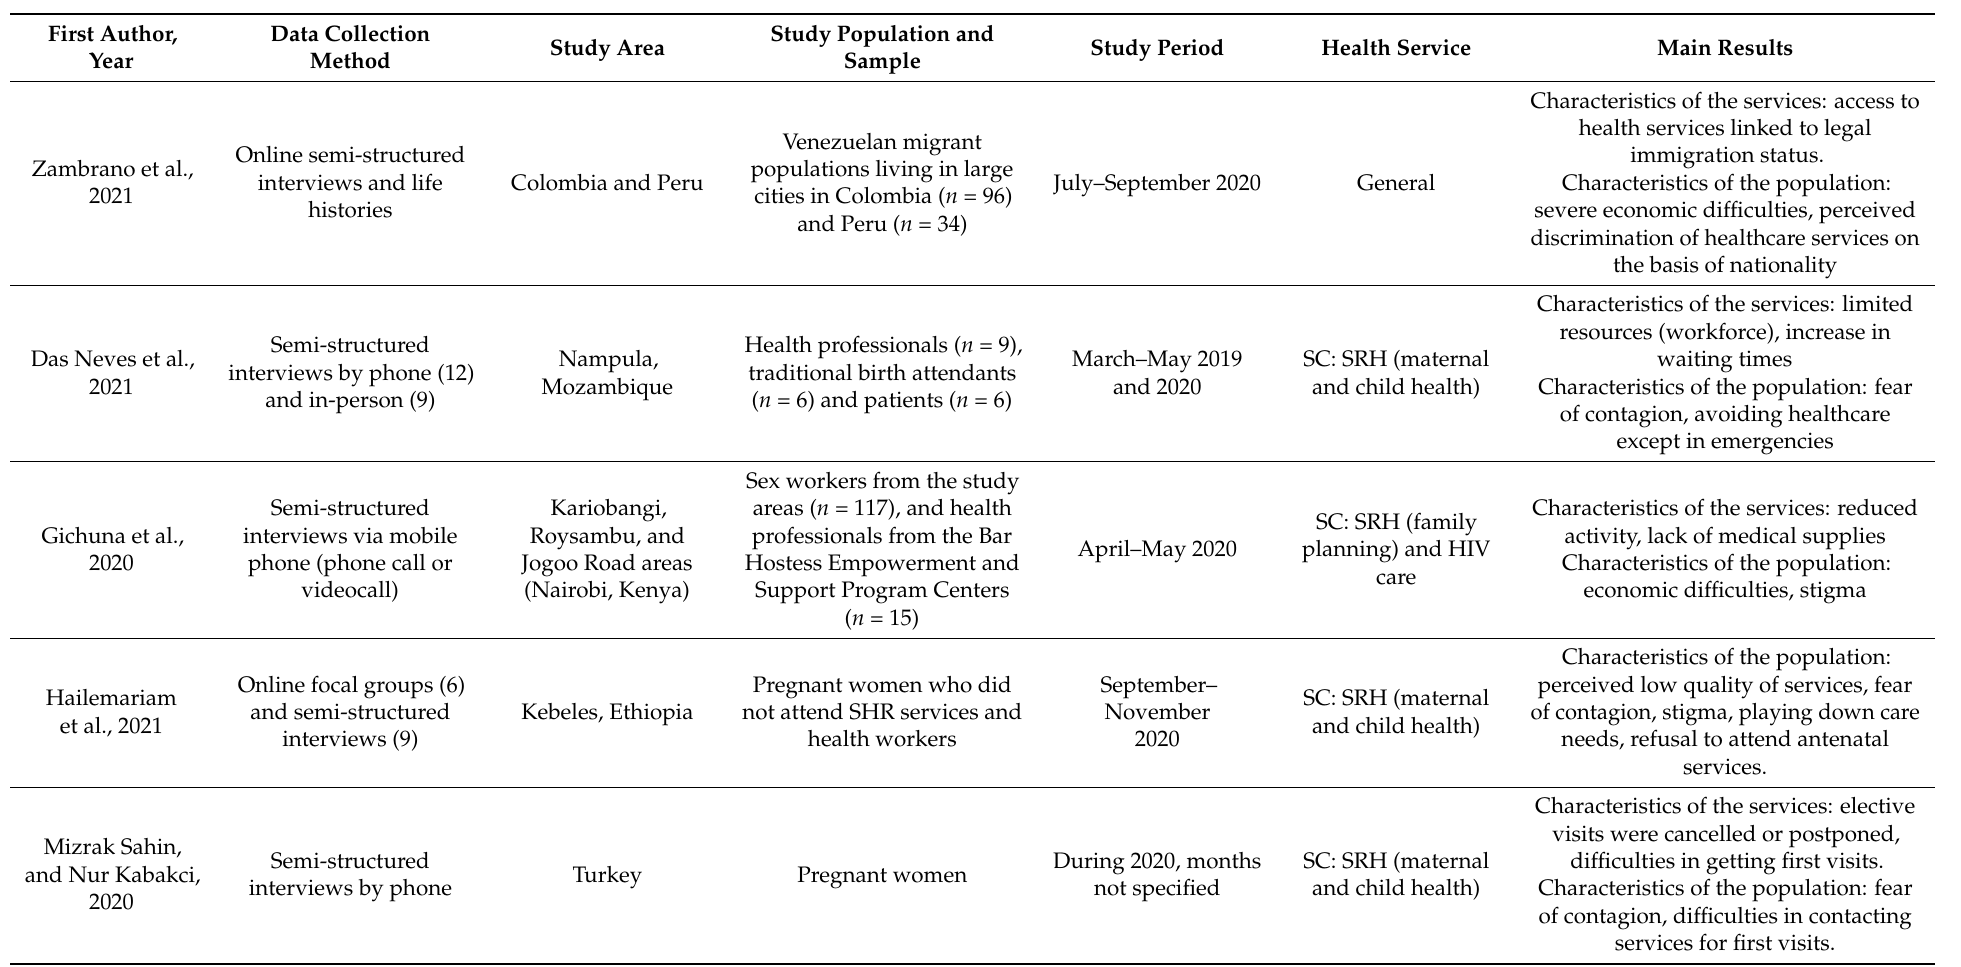
Table 3. Qualitative studies on potential access related to the characteristics of the services and the population during the COVID-19 pandemic in